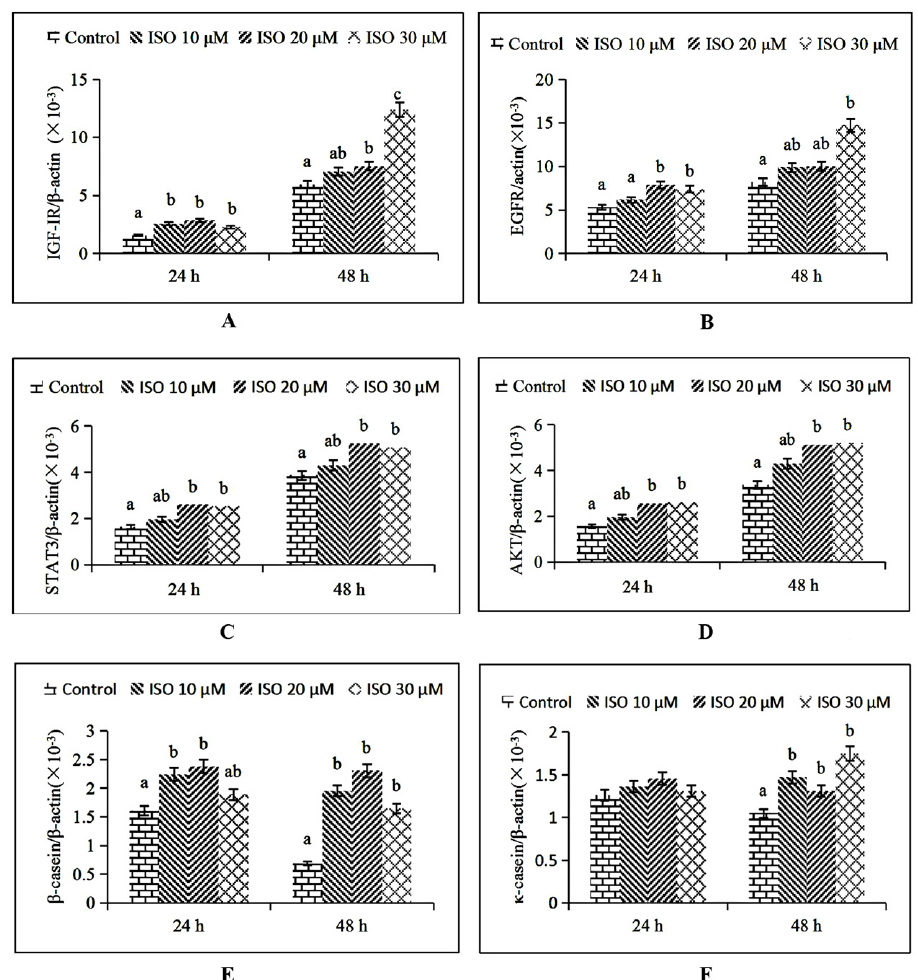
Figure 6. Effects of ISO on key genes expression related to cell function. After ISO added to the cells, cells were then collected at different time points (24 and 48 h), and the mRNA expression levels of the IGF-1R, EGFR, STAT3, AKT, β -casein, and κ - casein genes were measured by RT-qPCR ( A – F ). The chicken β -actin gene was used as the reference gene. Different letters on the histogram indicate significant differences ( p < 0.05) in the mRNA expression of each group. Each value was mean ± SD ( n = 3). IGF-1R = Insulin-like growth factor-1R; EGFR = Epidermal growth factor receptor; STAT3 = Signal transducer and activator of transcription 3; AKT = protein kinase B.